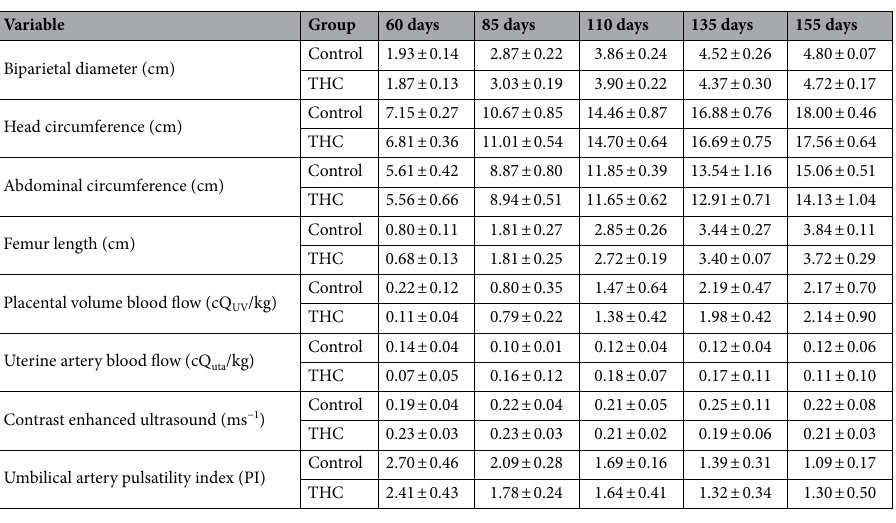
Table 1. Doppler and contrast-enhanced ultrasound measurements by gestational age timepoint. CSA (cross section of uterine artery) = π(diameter/2) 2 . Vmean (mean velocity) = 0.5 × maximum umbilical vein velocity. cQuta (uterine artery blood flow) = VTI × CSA × HR adjusted for maternal weight. cQuv (placental volume blood flow) = Vmean × CSA × 60. BPD biparietal diameter, AC abdominal circumference, FL femur length, PI pulsatility index, VTI velocity time